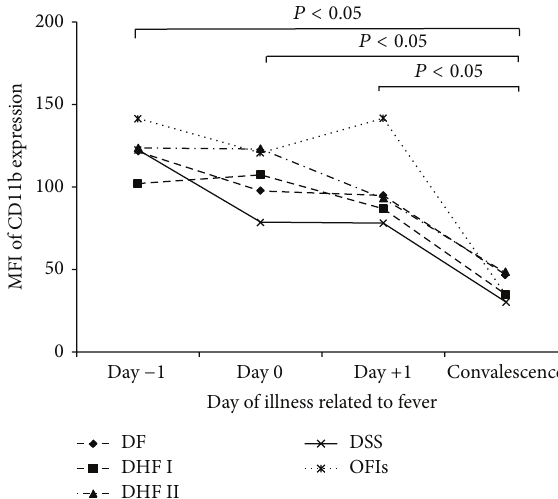
IL-1 𝛽 , versus LPS-stimulated IL-1 𝛽 , and versus MFI of CD11b expression,